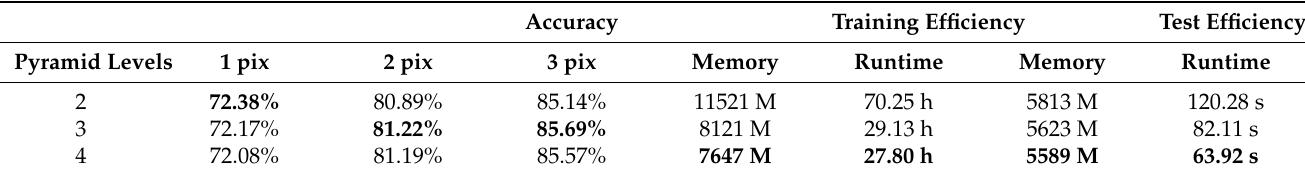
Table 4. Accuracy and efficiency comparison for GA-Net-PyramidED with different pyramid levels.